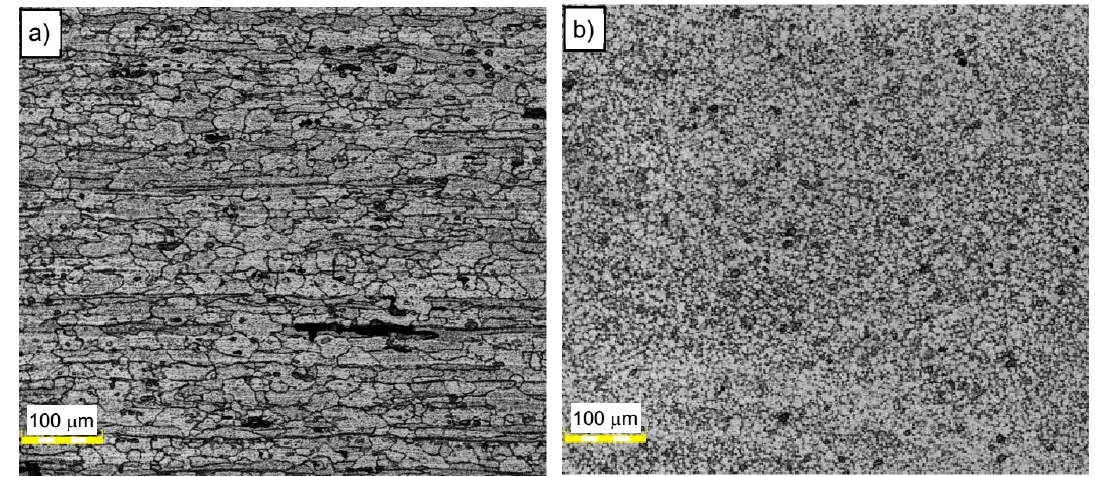
Figure 4. Microstructure of ( a ) base material AA5083 and ( b ) stir zone (SZ) in the A5_5-2 sample.